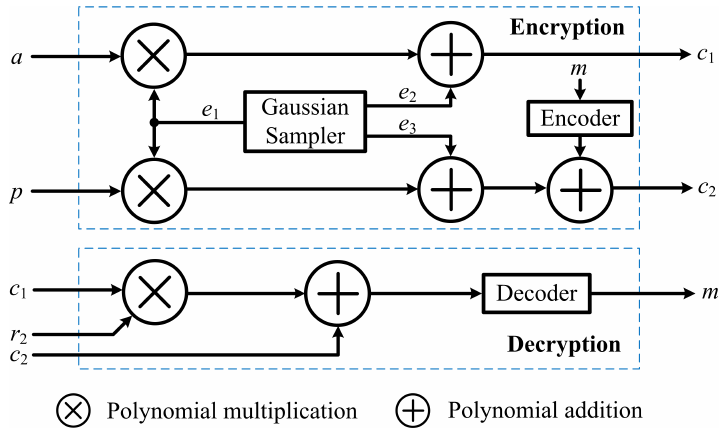
Figure 1. Block diagram of ring-learning with errors (LWE)